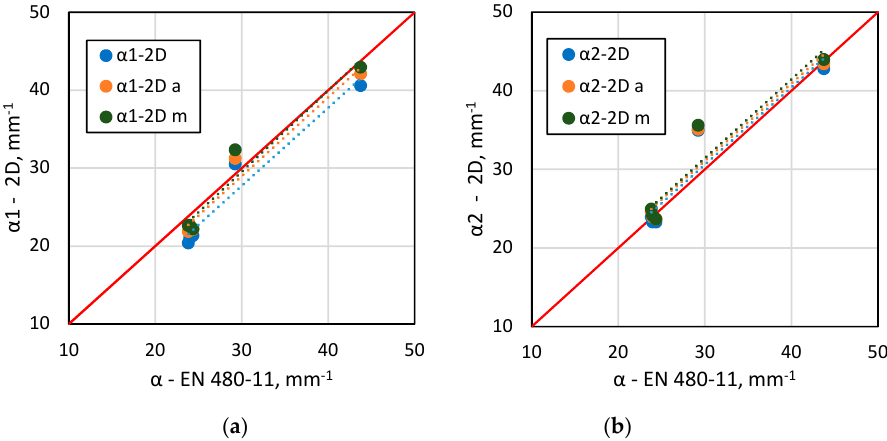
Figure 6. A comparison of EN 480-11 data versus 2D analysis results for α : a ) equivalent diameter based 2D analysis; b ) perimeter based 2D analysis.